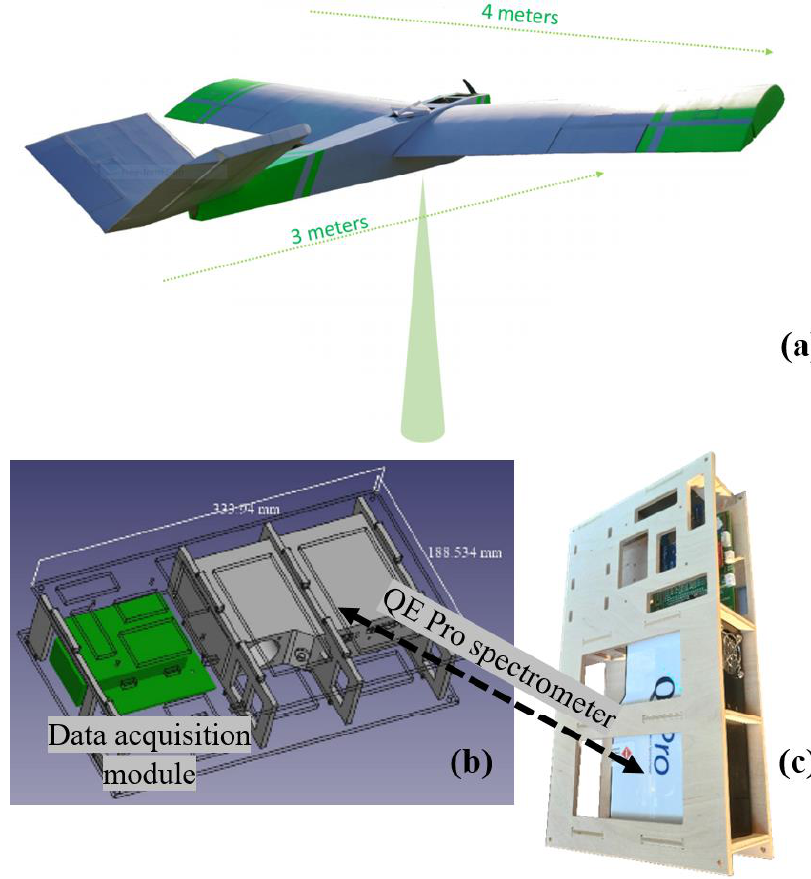
Figure 6. The FloXPlane fixed wing UAS ( a ), equipped with AirFloX system ( b , c ).